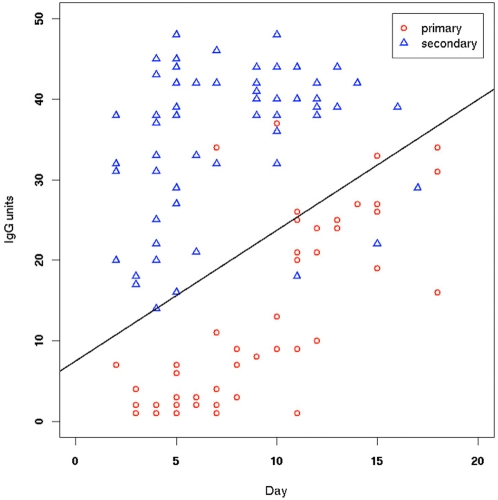
Independent test data, with primary and secondary infection classification according to the CPqAM criteria, with a solid line representing the previously designed classifier, for inspection.Test data were obtained from 50 additional patients in the cohort. As with the training data, all quantified samples were pooled and those that had been obtained more than 20 days after the onset of symptoms were ignored, resulting in 51 primary and 61 secondary infection samples, according to the CPqAM criteria, for a total of 112 test samples.